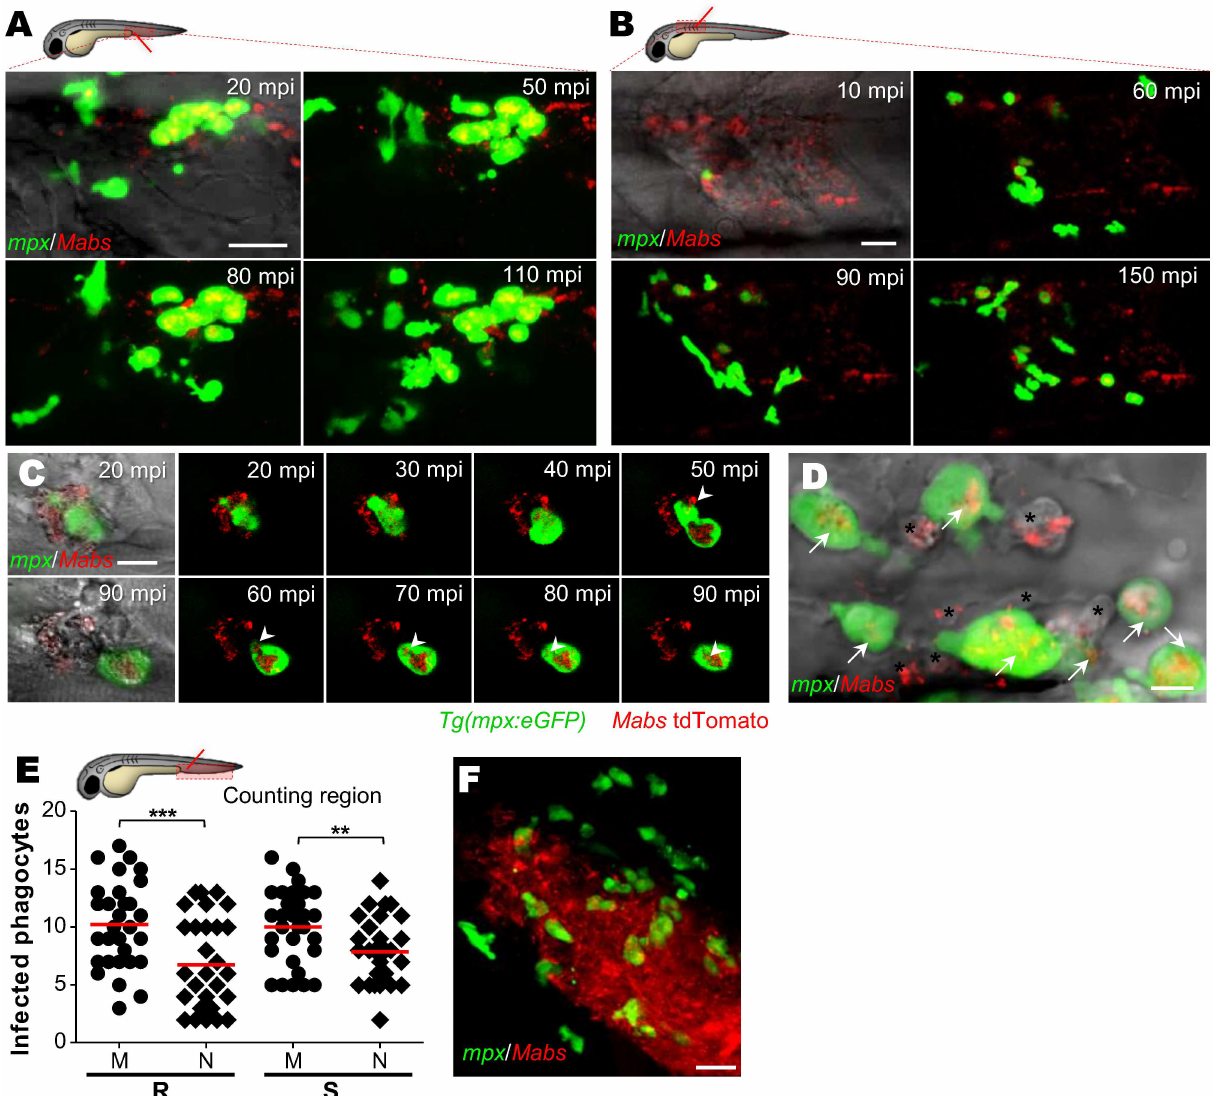
Fig 4. M . abscessus infections are associated with a massiveneutrophil mobilization. (A-D) Confocal live imaging of Tg(mpx : eGFP) larvae after iv (A and D) or intramuscular (B and C) infection with (cid:25) 100 Mabs R (tdTomato). (A-B) Time-lapse of neutrophils recruitment in caudal vein (A), monitoredfrom 20 mpi to 110 mpi, or into muscle (B) monitored from 10 mpi to 150 mpi. Scale bars, 20 μ m. (C) Recruited neutrophils phagocytizing individualmycobacteria. Scale bar, 5 μ m. (D) Neutrophils (arrows) and presumptive macrophages ( * ), containing mycobacteria. Scale bar, 20 μ m. (E) Number of infected neutrophilsand macrophages counted in CHT at 4 hrs post intravenous infection with both Mabs variants ( (cid:25) 150 CFU, three independent experiments, horizontallines indicate mean values). M, macrophage; N, neutrophils. Statistical significance was determinedby one-tailed unpairedStudent’s t test. (F) Confocal imaging of neutrophil-bacteria interactions in the context of R-abscess. Scale bars, 20 μ m. See also S1